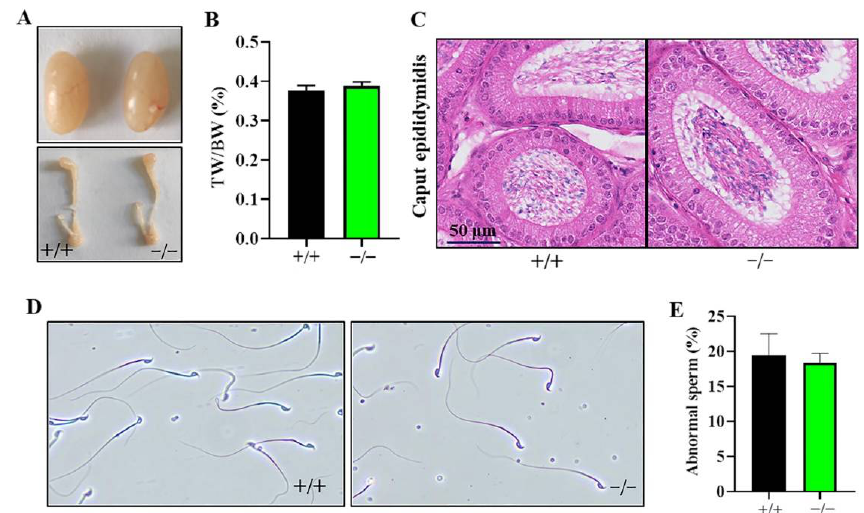
Figure 3. Development and morphology of testis, epididymis, and sperm in knockout (KO) mice. ( A ) The contrast of testis and epididymis between WT and KO mice. ( B ) The ratio of testicular weight to body weight in WT and KO mice. ( C ) Morphological changes of caput epididymis of WT and KO mice. Sections were analyzed by hematoxylin + eosin (HE) staining. ( D ) Sperm morphology analysis in WT and KO groups. Observation of sperm smears were performed under a microscope in 2.5 months old mice. ( E ) The statistical data of abnormal sperm come from ( D ). Data are the mean ± SEM ( n = 5).